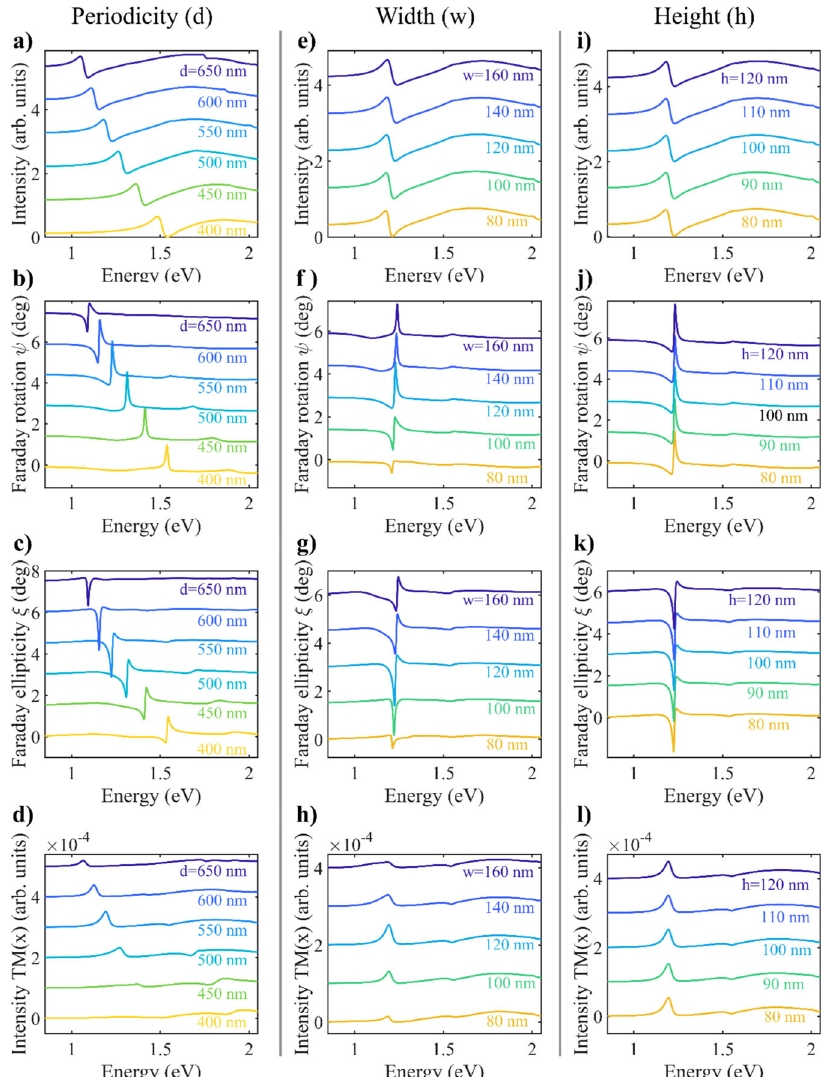
Fig. 2 The dependence of the enhanced Faraday rotation and ellipticity on the geometrical parameters of the Fano resonant waveguide magneto- plasmonic crystal (WMPC) system with transverse electric (TE) polarized excitation. The fi nite element method (FEM) simulated transmission spectra, the spectral variation of the Faraday rotation ψ , ellipticity ξ , and the transmitted transverse magnetic (TM) polarization intensities of the WMPC are shown for varying periodicity ( d , ( a ), ( b ), ( c ), ( d )), width ( w, ( e ), ( f ), ( g ), ( h )), and height ( h , ( i ), ( j ), ( k ), ( l )) of the gold (Au) gratings (shown for E ¼ _ ω ¼ 0 : 83to2 : 067eV), here _ is the reduced Planck ’ s constant and ω is the frequency. Prominent signatures of Fano resonance with asymmetric spectral line shape are observed in all the transmission spectra ( a , e , i ). Large enhancements of the Faraday rotation ( b , f , j ) and ellipticity ( c , g , k ) are observed around the Fano spectral dip ( E ¼ _ ω F ) for all the geometrical parameters. The spectral variation of the transmitted transverse magnetic (TM) polarization intensities ( d , h , l ) is also shown for each of the varying geometrical parameters of the WMPC. The periodicity ( d ) parameter of the grating is varied from 400 to 650 nm with a step size of 50 nm, keeping fi xed width ( w = 120 nm) and height ( h = 100 nm). Similarly, the w parameter of the grating is varied from 80 to 160 nm in a step of 20 nm with a fi xed d = 550nm and h = 100 nm. The h parameter is increased from 80 to 120 nm with a step of 10 nm for a fi xed d = 550 nm and w = 120 nm. In order to maintain clarity in the fi gures, the baseline magnitudes of Faraday rotation ψ and ellipticity ξ are shifted by (cid:4) 1.5 deg. consecutively for each sub-plot with varying periodicity, width and height of the Au comparison of the ampli fi ed Faraday rotation ψ (Fig. 3e) and the ellipticity ξ (Fig. 3f) with the exact theoretical predictions of natural WVA of Faraday effect in Fano resonance (using Eq. S4 and S6 of Supplementary information) shows good agreement.